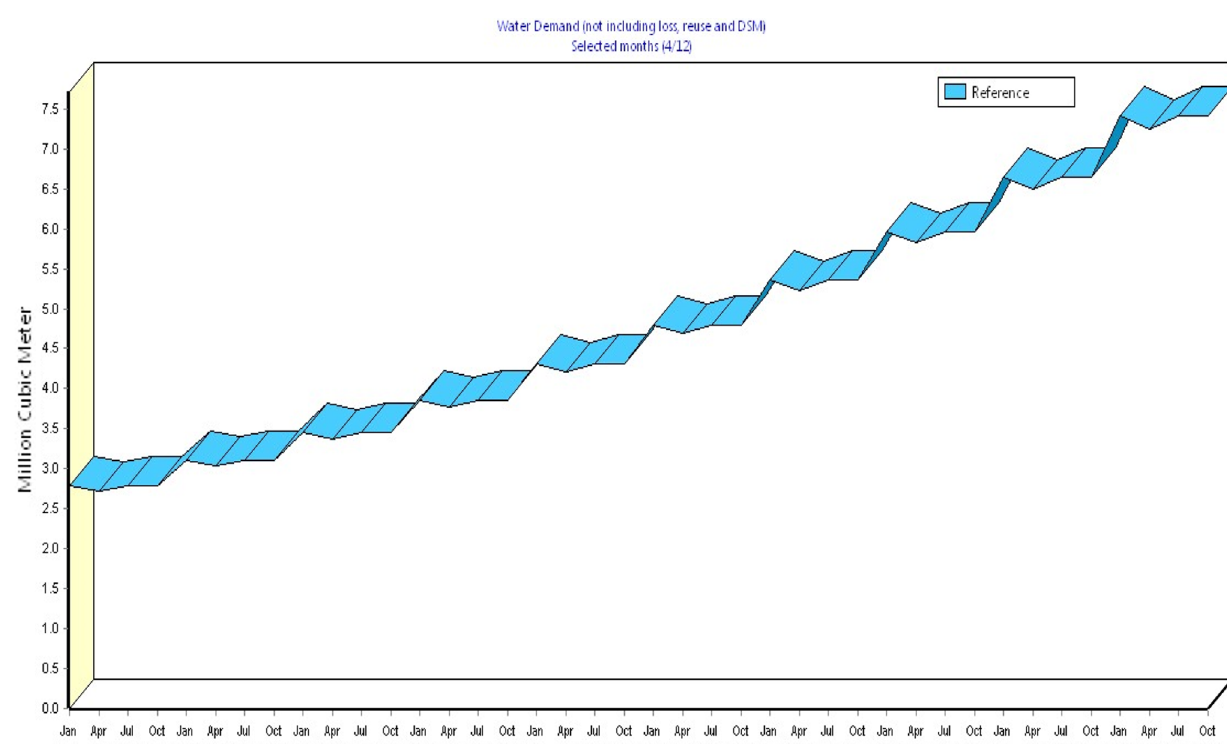
Fig. 6 Evolution of the monthly water demand in Bechar city—reference scenario; source: own